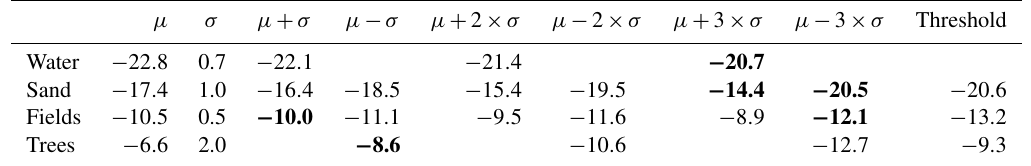
Table B4. Determination of thresholds for a sampling duration of 7 months, unfiltered. Values in bold are those that have been used to calculate the threshold indicated in the last column. All values are in decibels (dB). µ – mean. σ – standard deviation.